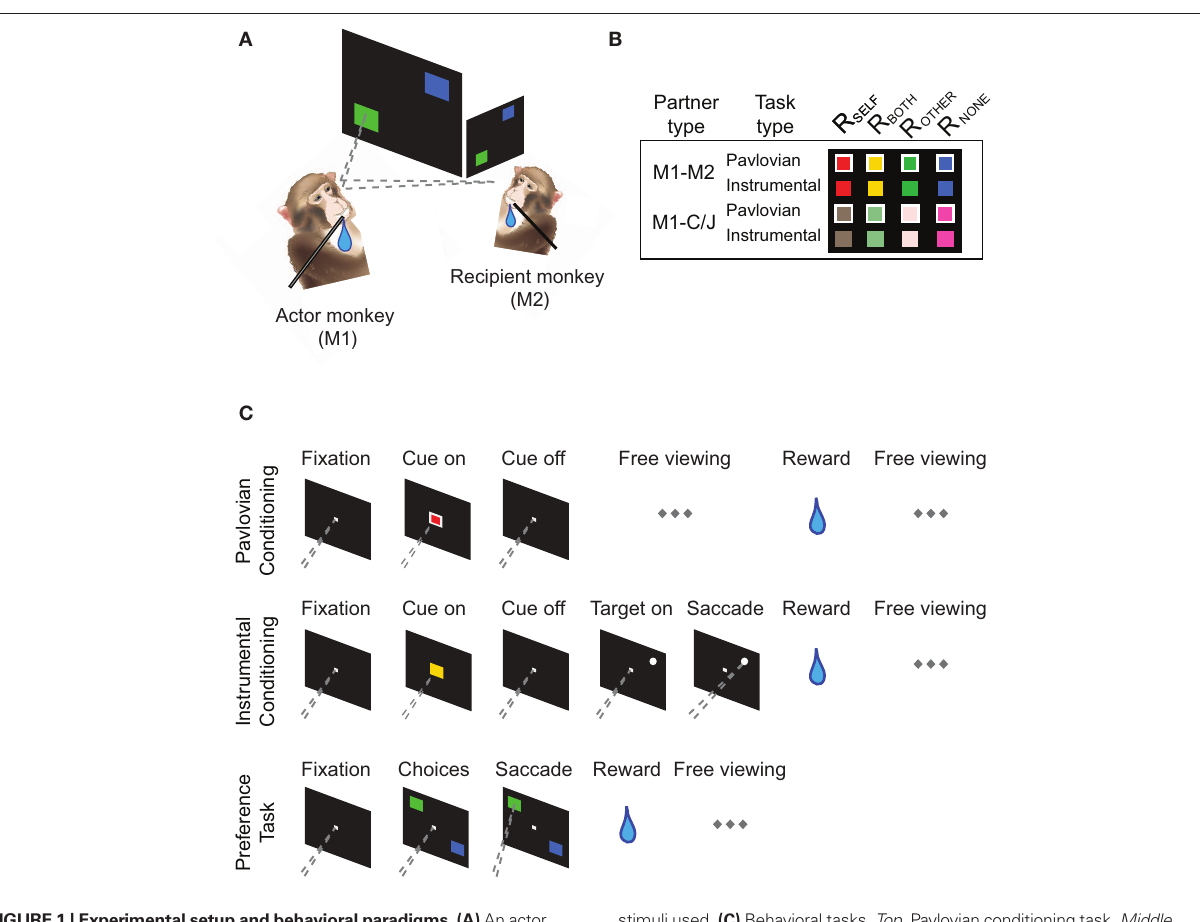
Figure 1 | experimental setup and behavioral paradigms. (A) An actor monkey (M1) performed behavioral tasks in the presence of a recipient monkey (M2) in a dimly lit room. (B) Typical stimuli used for the monkey–monkey (M1–M2) and monkey–chair/juice (M1–C/J) conditions. See Table 1 for all the